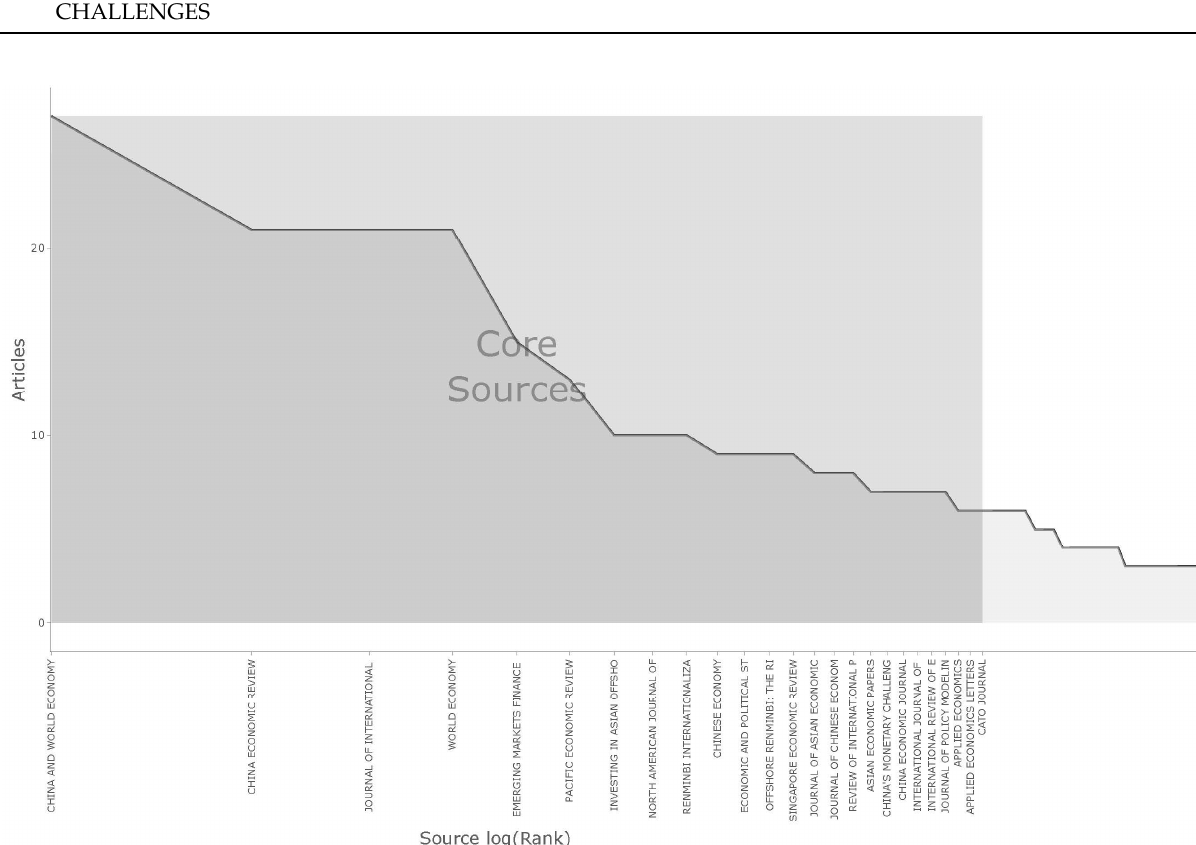
Figure 2. Core sources by Bradford’s Law. Source: Authors’ elaboration using Biblioshiny.